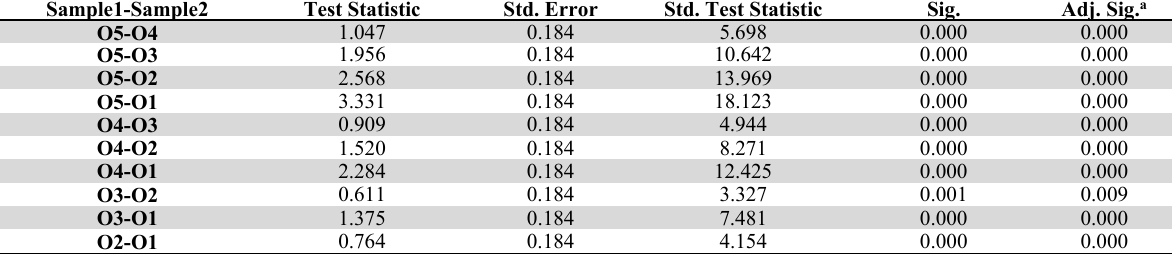
Bonferroni Dunn’s post hoc- Level of disruptiveness by 1 hour reliability issue scenarios